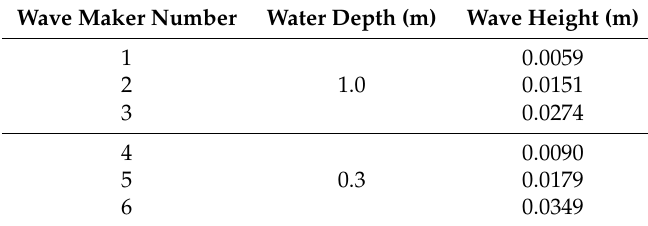
Table 4. Wave height associated with each wave maker.